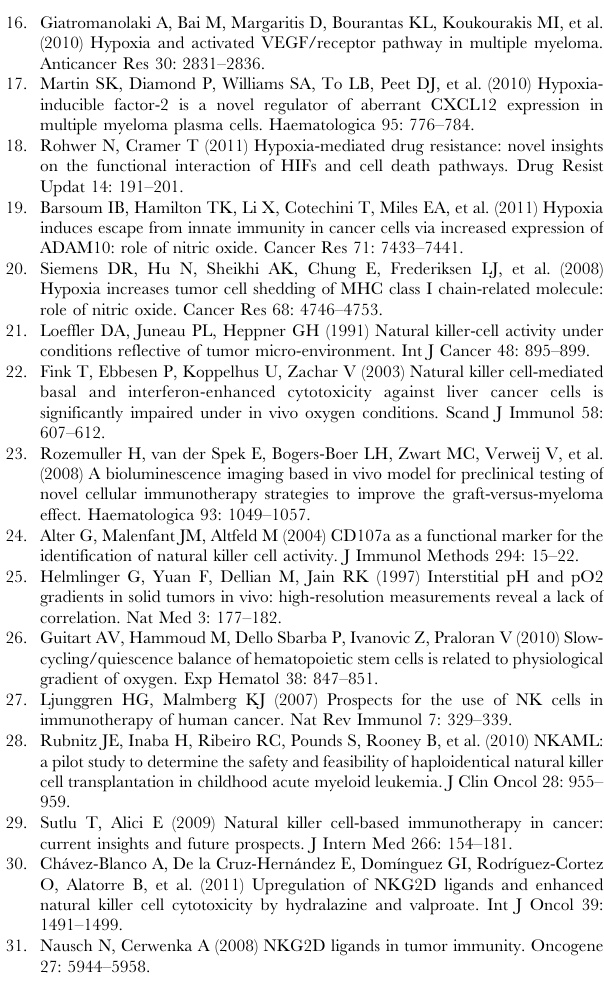
Figure S6 IL-2 activation increases CD107a expression on NK cells both 21% and 0% oxygen. NK- and